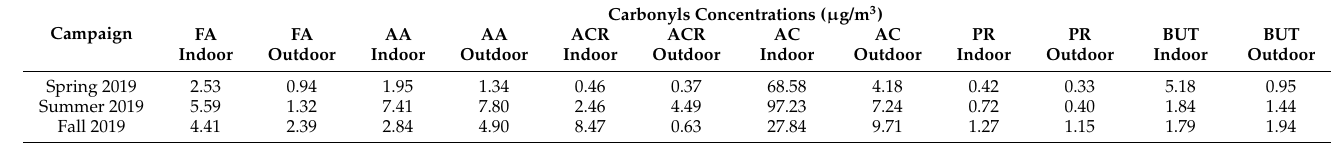
Table 4. Mean values of indoor-outdoor carbonyl concentrations during the three different sam- pling campaigns.